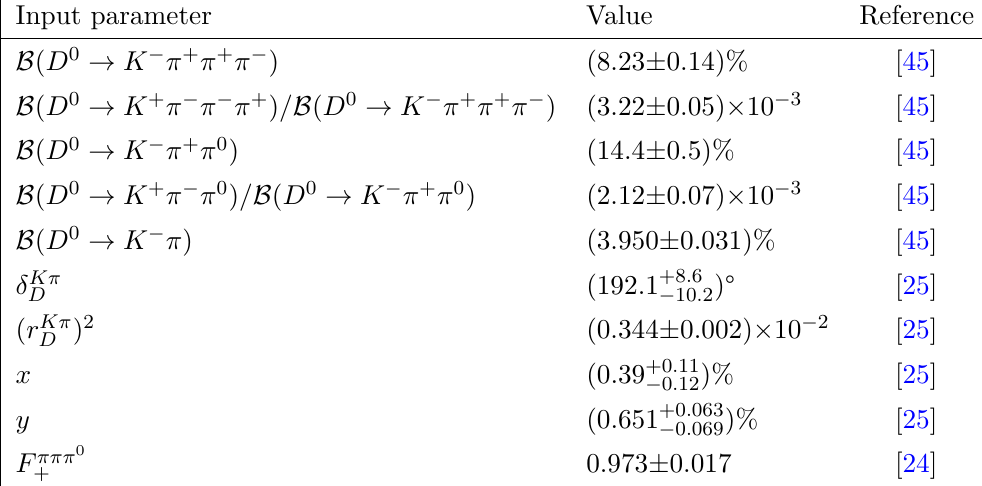
Table 6 . Input parameters used in the determination of the observables and hadronic